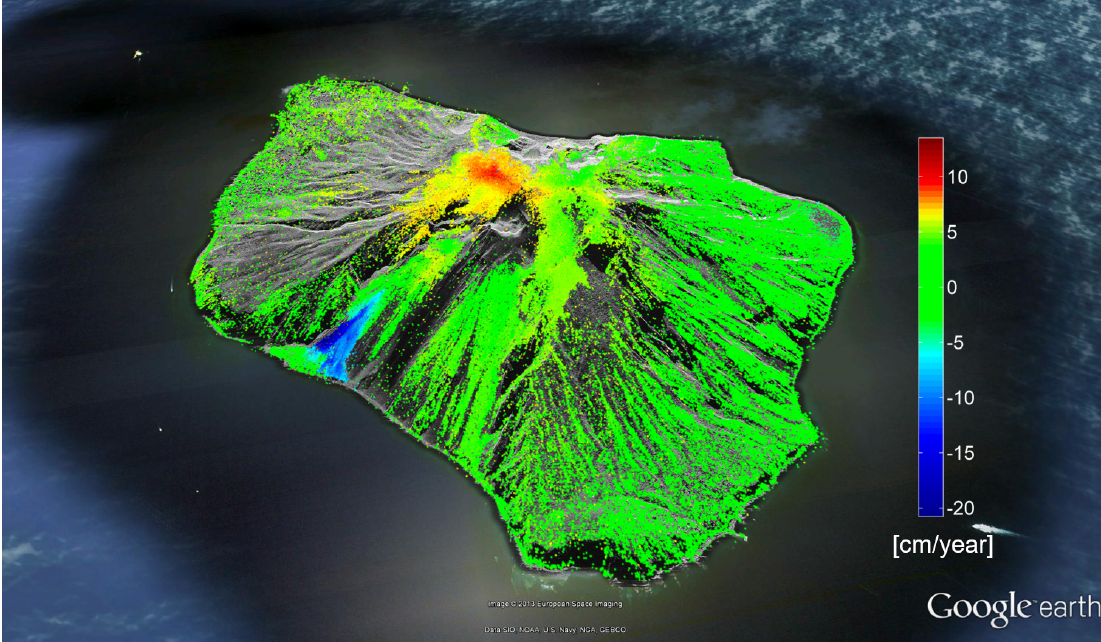
Figure 12. The linear deformation rate of the volcano Stromboli, in Italy, estimated by the robust DS phase history parameter retrieval method. In total, 16 interferograms acquired in 2008 were used. The crater shows an uplift of 10 cm/year, and the southern slope undergoes a subsidence of up to 20 cm/year. This may suggest certain displacement of the magma underneath the volcano. Courtesy: the tropospheric correction was done by Cong et